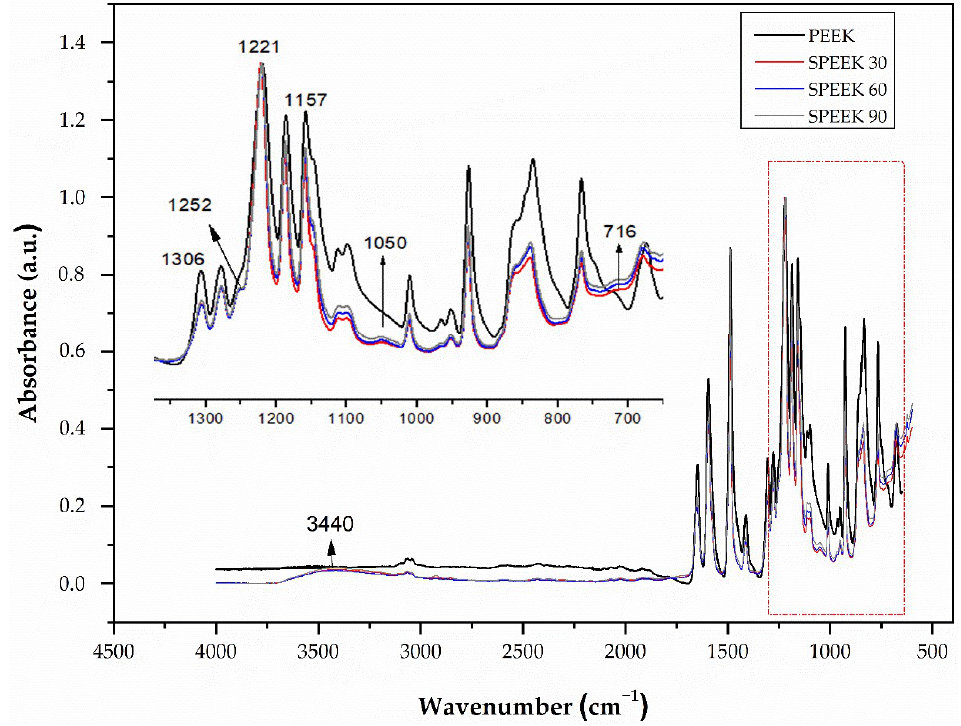
Figure 2. PEEK and SPEEK FTIR spectra with immersion times of 30, 60, and 90